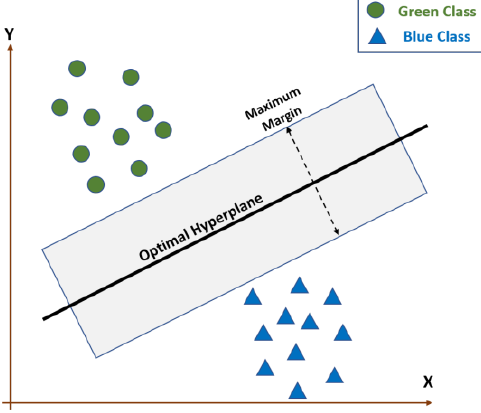
Figure 8. An illustration of the SVM Algorithm.